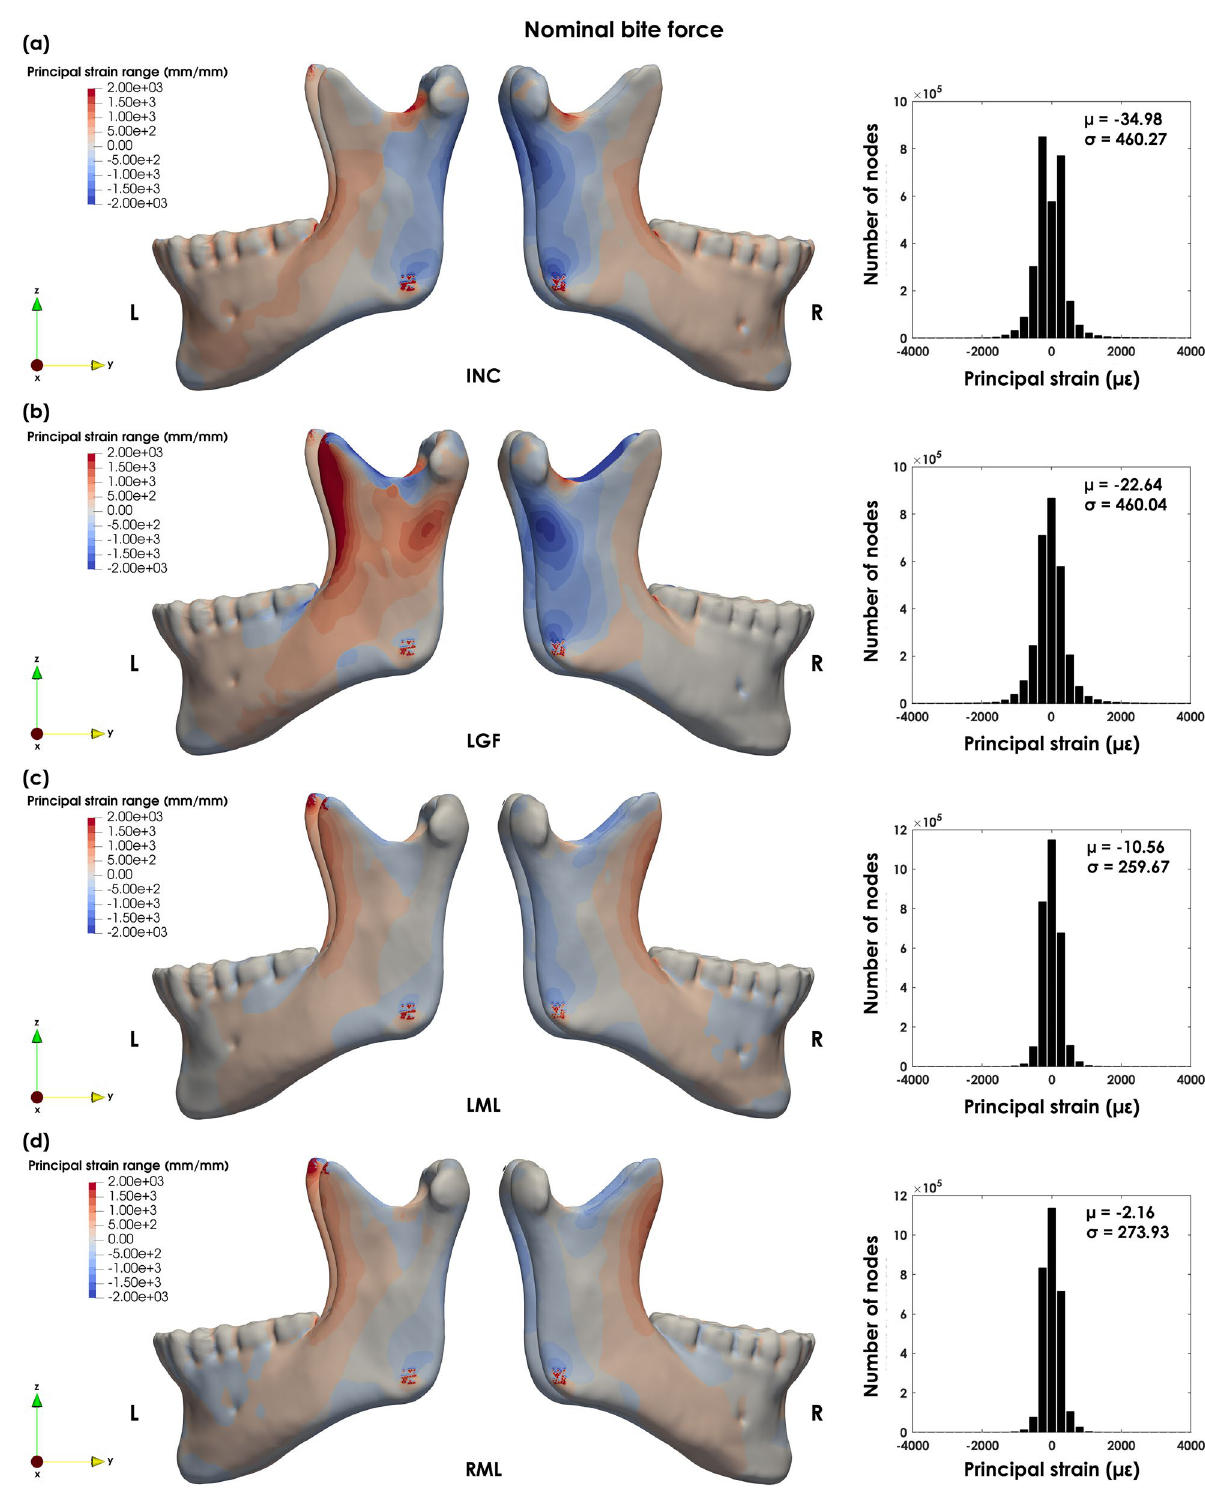
Figure 4. Lateral view of the principal strain distribution during ( a ) incisor biting (INC), ( b ) left group biting (LGF), ( c ) left molar biting (LML) and ( d ) right molar biting (RML) for the intact